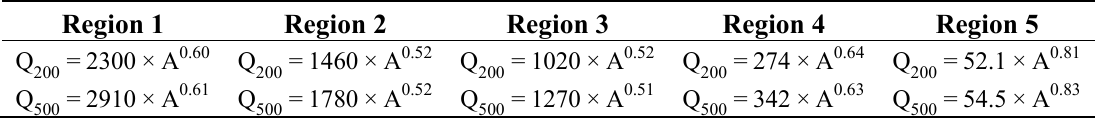
Table 3. Extrapolated 0.5- and 0.2-percent regional regression equations using Lara 1987 equations assuming a Log-Pearson Type III